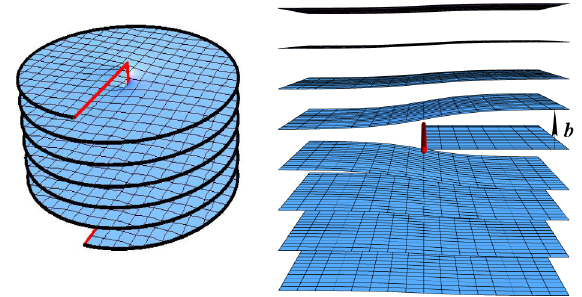
FIG. 6. Screw (left diagram) and edge (right diagram) dis- locations in 3D. Dislocations in an axion insulator harbor chiral modes, denoted by red lines in both figures. In the screw dislocation, thick black lines represent the standard chiral edge mode. The screw dislocation geometry with Weyl nodes split along the screw axis was used for the numerical results presented in Fig.